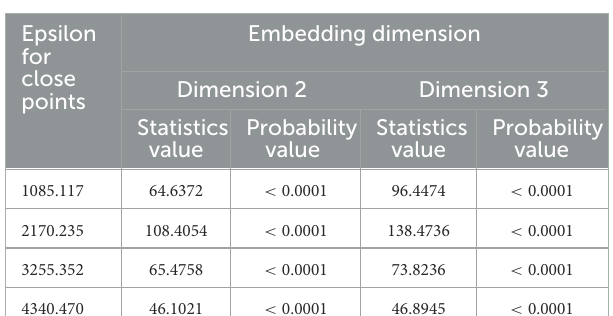
TABLE 2 BDS test